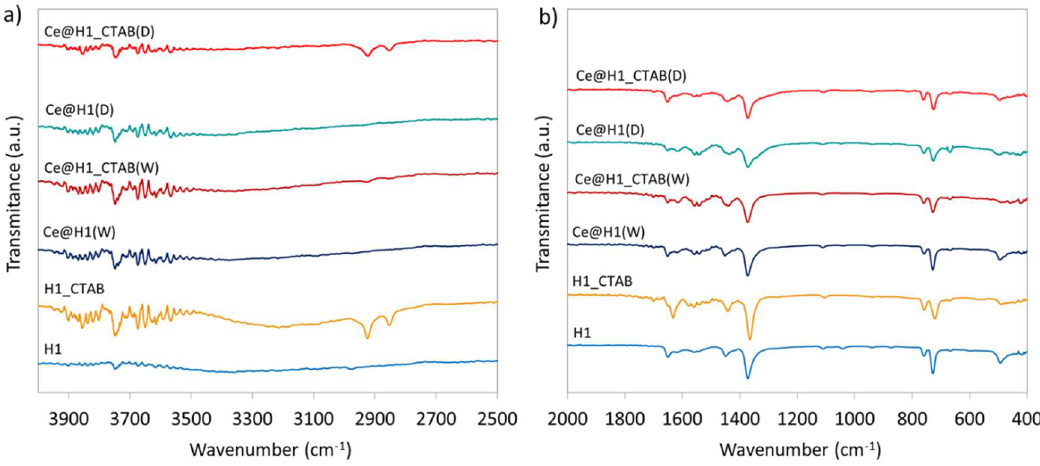
Figure 9. FTIR spectra of HKUST-1 and Ce@HKUST-1 materials in the 4000–2500 cm − 1 ( a ) and 2000–400 cm − 1 ( b ) range.